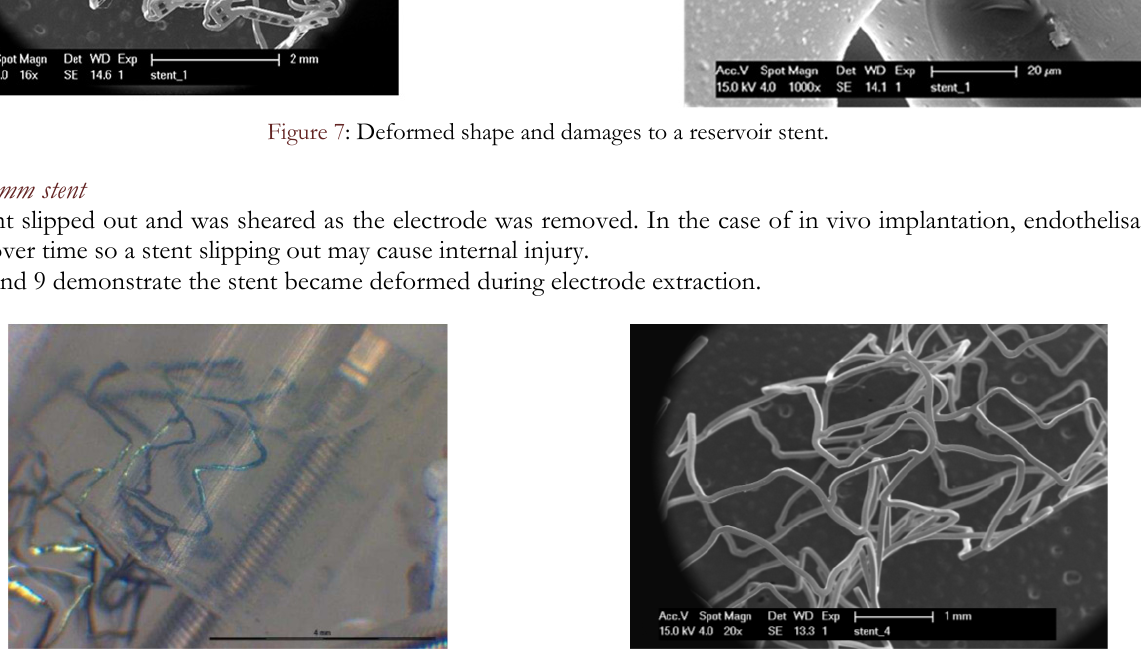
Figure 8: the beginning of electrode extraction Figure 9: “S”-shaped stent after